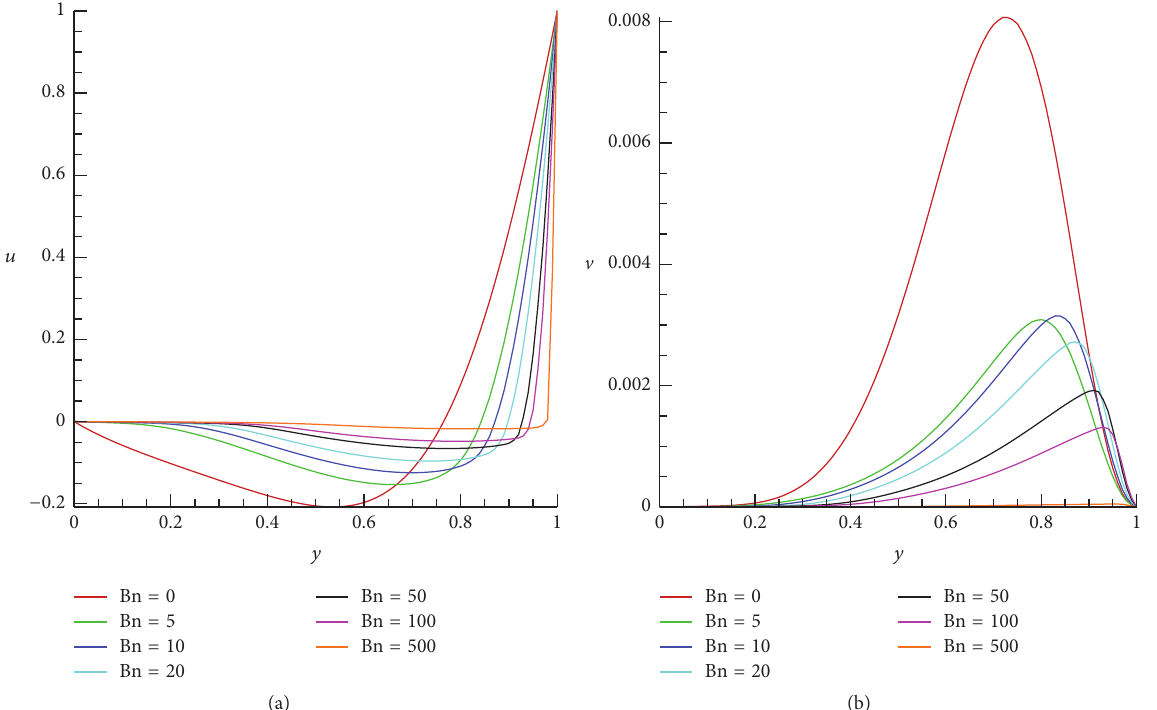
Figure 4: Vertical cut-lines at 𝑥 = 0.5 for 𝑢 velocity and V velocity for different values of Bingham number.